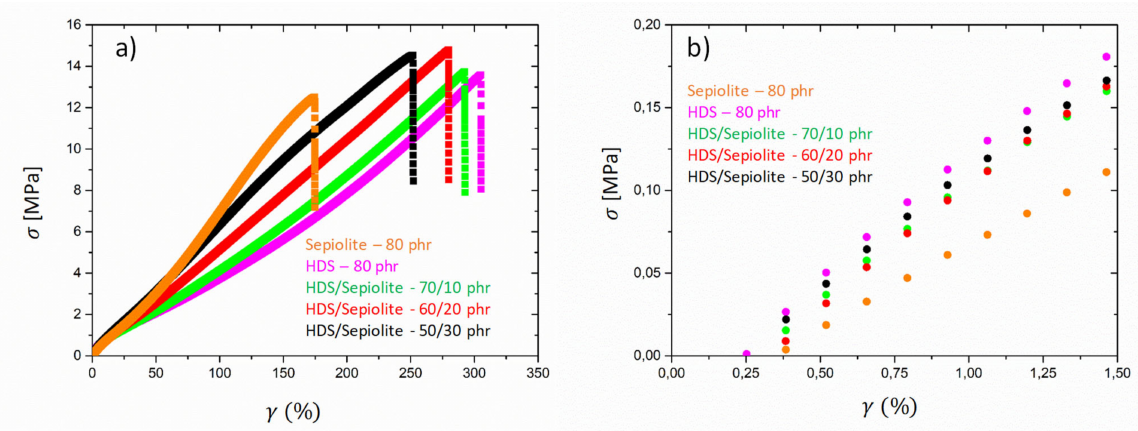
Figure 8. Stress-strain curves for mixtures of Sepiolite and HDS Silica dual filler compounds in the full deformation range ( a ) and at low deformation ( b